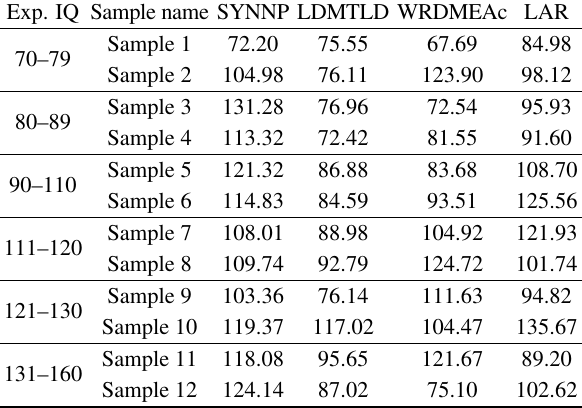
Table 5 Calculated IQ scores from Abramov and Yampolskiy [35]